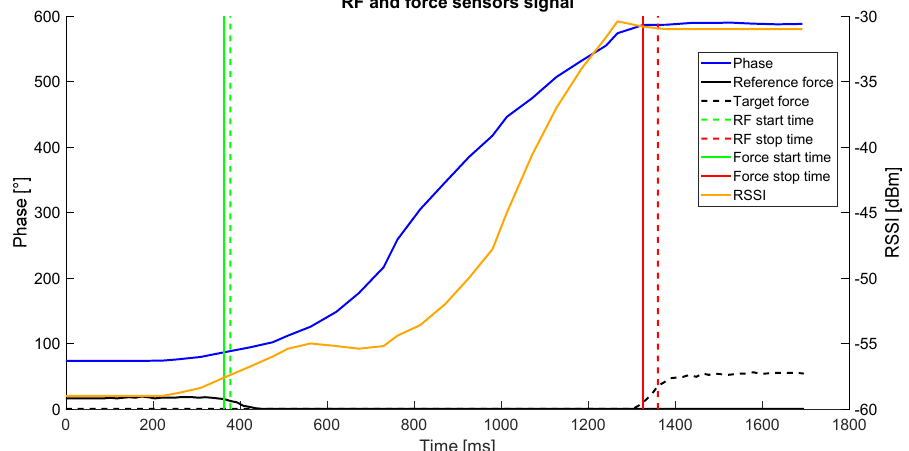
Figure 5. RF and force sensors data acquired during a reaching task. The continuous blue line represents the phase signal; the continuous orange line represents the received signal strength indicator (RSSI) signal; the continuous black line represents the force signal of the reference position; the dashed black line represents the force signal of the target position; the vertical green line and the vertical red line represent the movement starting time and end time respectively identified through the RF signals; the vertical dashed green line and the vertical dashed red line represent the movement starting time and end time respectively identified through the RF signals.